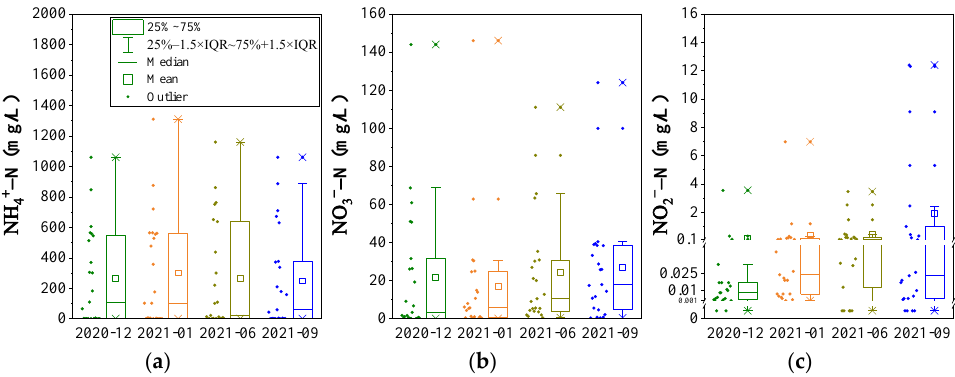
Figure 2. The box diagram of ammonia-nitrogen ( a ), nitrate-nitrogen ( b ), and nitrite-nitrogen ( c ) in groundwater.